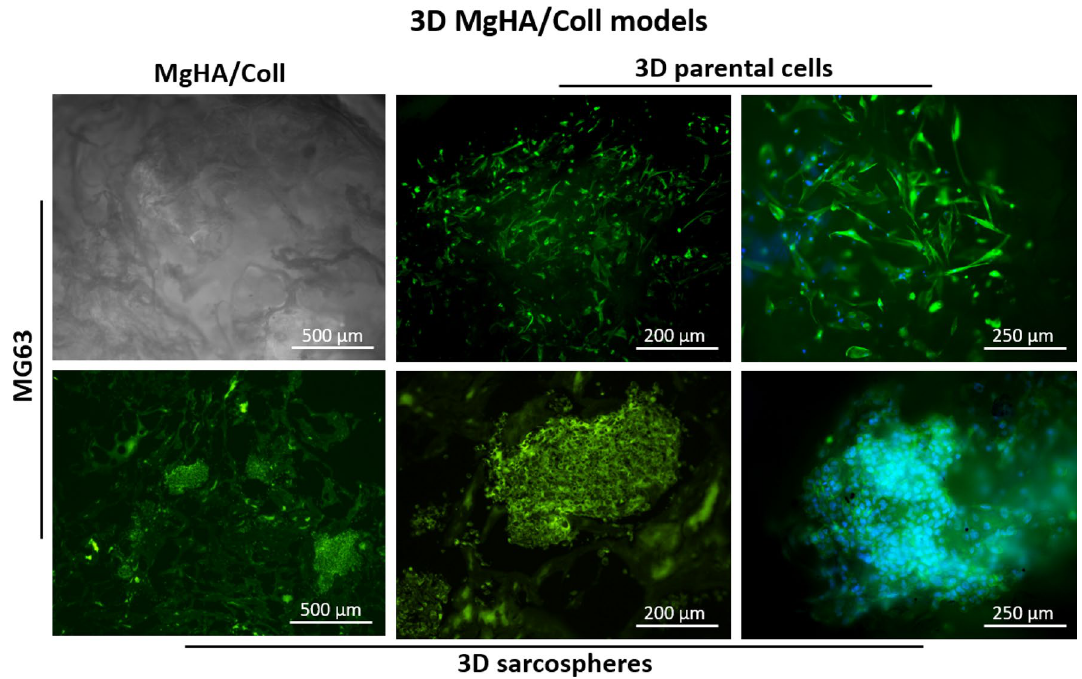
Figure 4. Fluorescence analysis of the 3D MgHA/Coll model of MG63 sarcospheres and parental cells. The top left figure is a representative image of the MgHA/Coll material. The panel shows the two cell phenotypes and their interaction with the hybrid material; cell nuclei in blue (DAPI) and F-actin filaments in green (Phalloidin).